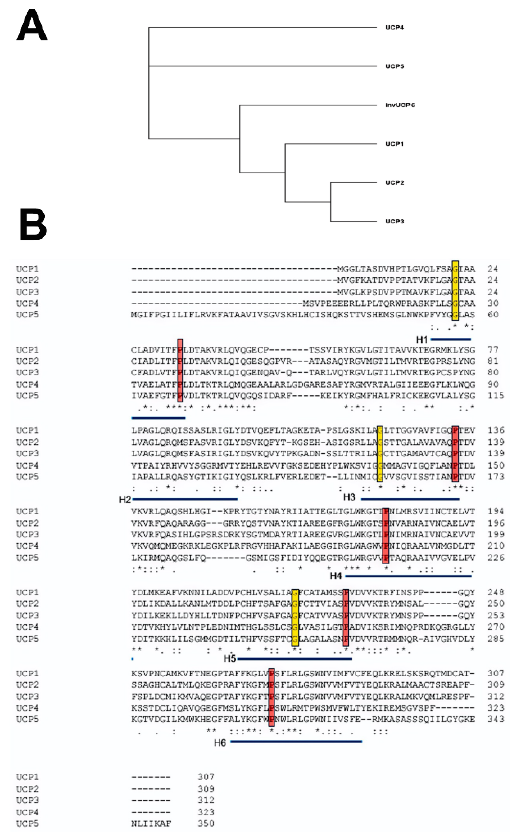
Figure 1. ( A ) A simplified phylogenetic tree of human UCPs. From the sequences in B, we derived a tree indicating the early divergence of UCP4 and 5 and a later divergence into invertebrate UCPs and a precursor of UCP1, 2 and 3. ( B ) Sequence alignment of the five human UCP proteins. Sequences used for alignment were the RefSeqs UCP1 (NP_068605.1), UCP2 (NP_003346.2), UCP3 (NP_003347.1), UCP4 (NP_004268.3) and UCP5 (XP_016885426.1). Alignment was carried out using the Clustal Omega program [26]. Conserved residues are marked with “*”, and conserved residues with “.” or “:”. The transmembrane helices are underlined in blue, key prolines in these helices outlined in red, and highly conserved glycines in yellow. Adapted from [2].